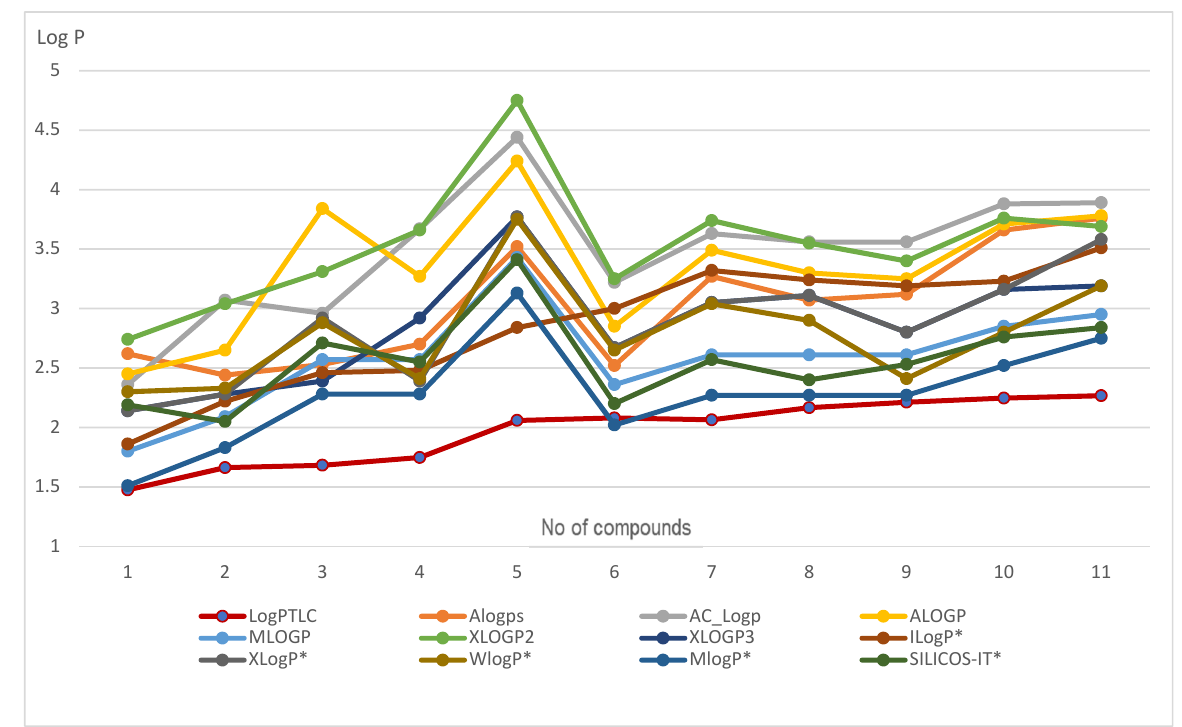
Figure 4. Graphical visualization of calculated logP values (using SwissADME models) of the tested compounds with comparison of logP TLC (plotted in red). *-data obtained using the SwissADME server.